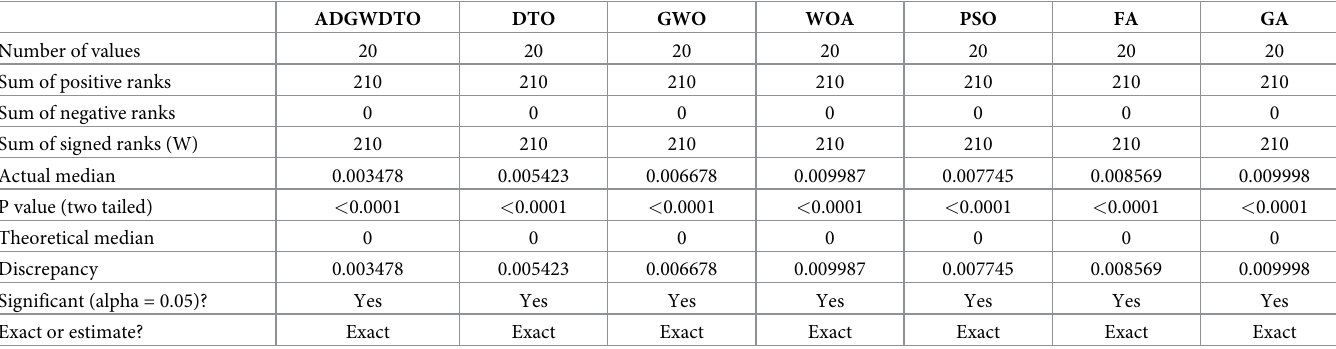
Table 10. Wilcoxon signed rank test results of the proposed algorithm compared to state-of-the-art algorithms. ADGWDTO DTO